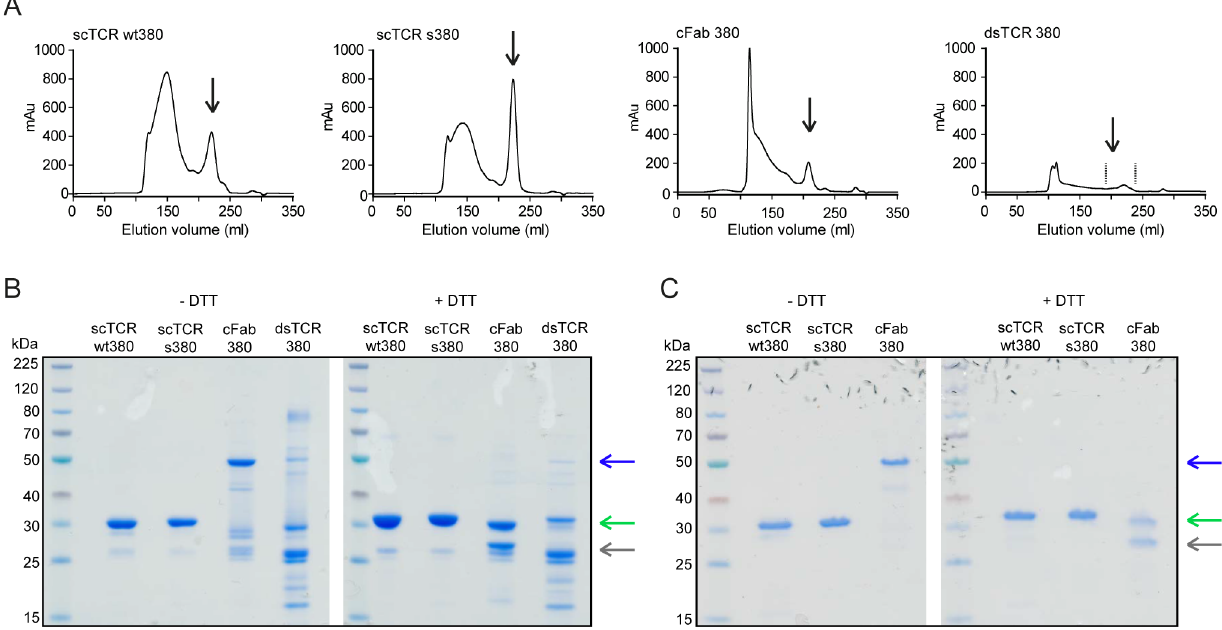
Fig 3. Purification profile and monomeric integrity of the expressed recombinant TCR formats. (A) Representative Superdex 200 SEC profiles of IMAC purified scTCR wt380, scTCR s380, cFab 380 and dsTCR 380 as indicated ( n = 2–9). Elution volumes corresponding to the expected size of monomeric scTCRs and heterodimeric cFab 380 and dsTCR 380 are indicated by arrows. Notably, for the dsTCR we pooled several fractions as indicated by the dotted lines due to the lack of a clear peak indicating the elution volume of the dsTCR. (B) Representative non-reducing and reducing SDS-PAGE of SEC purified monomeric TCR fractions ( n = 2). (C) Non-reducing and reducing SDS-PAGE of Resource Q/Superdex 75 purified monomeric and heterodimeric TCR fractions ( n = 2). (B, C) Bands at about 32 kDa for the scTCRs, 55 kDa and 26/29 kDa for the cFab and 57 kDa and 25/32 kDa the dsTCR depending on non-reducing or reducing conditions are indicated with arrows (blue arrows for heterodimeric cFab and dsTCR, green arrows for scTCR and reduced β -chains and grey arrow for reduced α -chains.